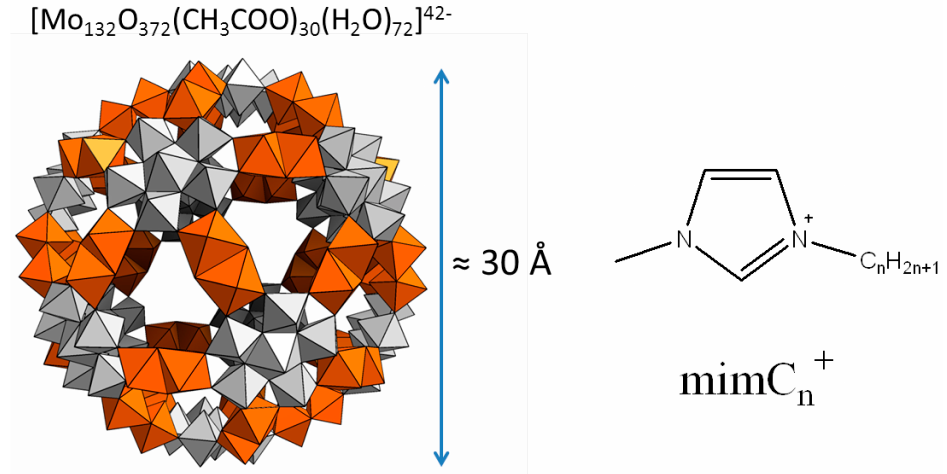
Figure 1. Representation of the Keplerate nano capsule Mo 132 and the imidazolium cations used in this study. The grey polyhedra correspond to the fragments {Mo 6 O 21 }, whereas the polyhedra in orange correspond to the linkers {Mo 2 O 4 }. Acetates ligands are found inside the cavity of the capsule and are not shown in the